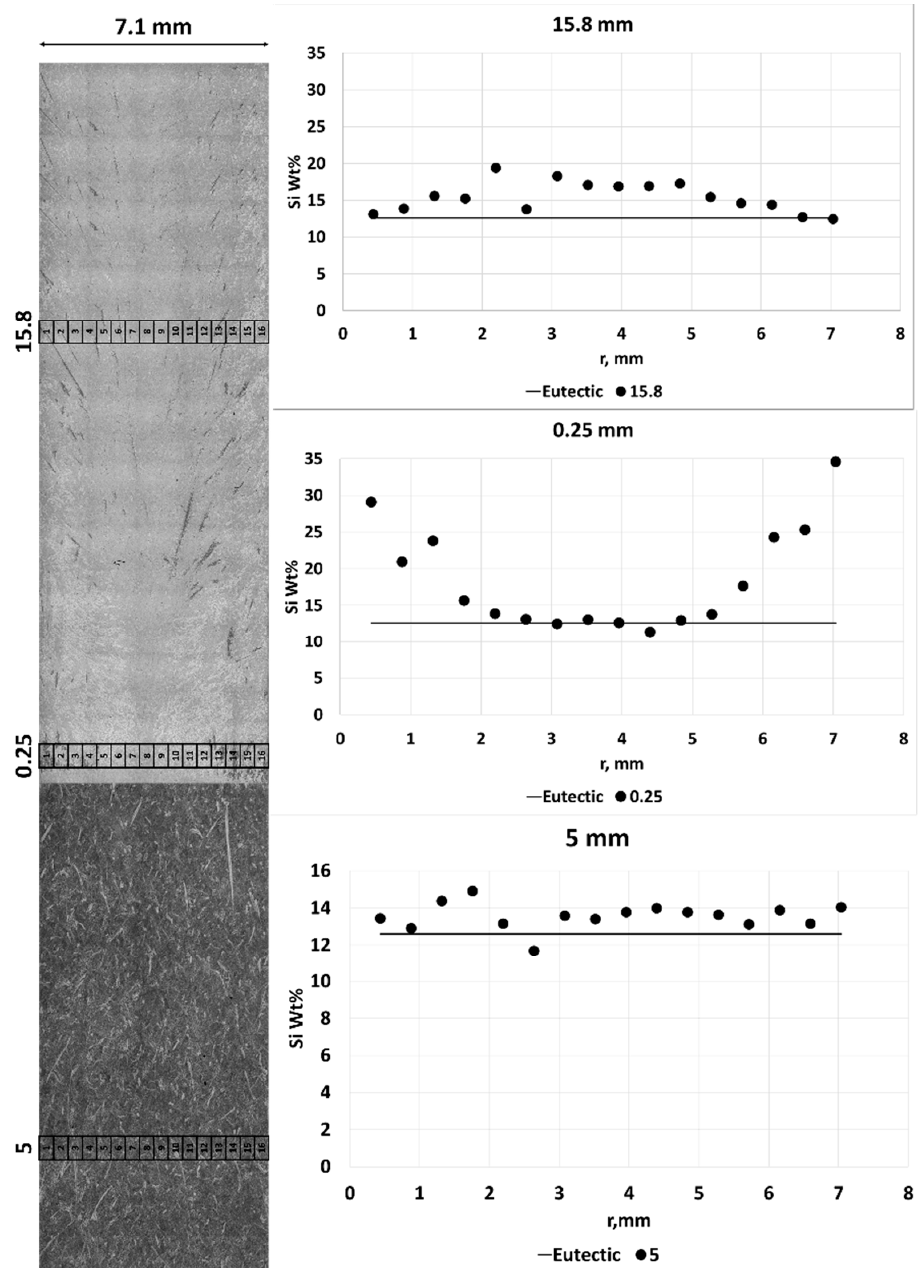
Figure 9. Si-concentration distribution along the diameter in C sample at steps 3 and 4.